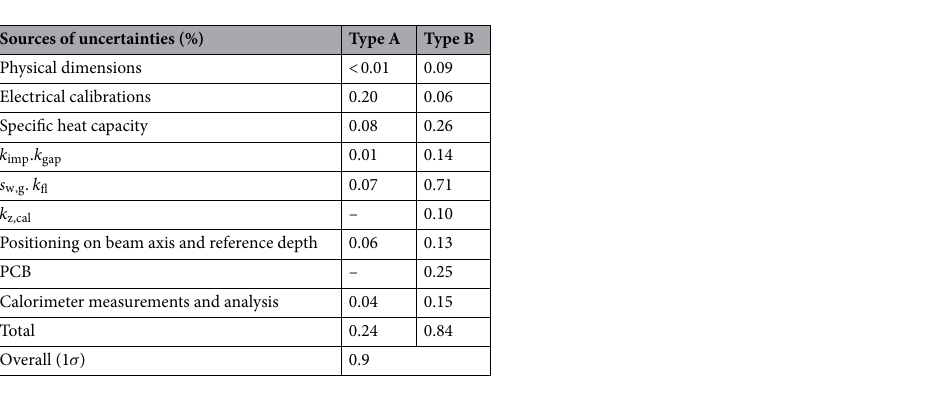
Table 2. Relative uncertainty of absorbed dose-to-water measured by the NPL PSPC at CCHMC.